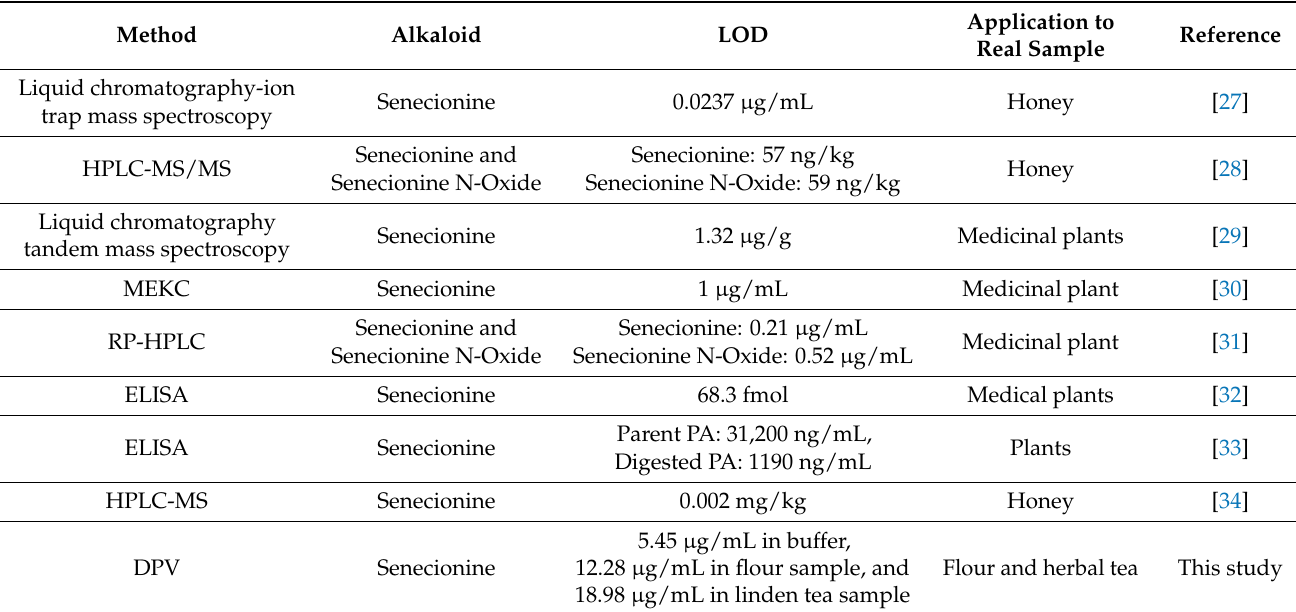
Table 2. The comparison of our assay over some earlier reports on SEN detection protocols with LOD and application to real